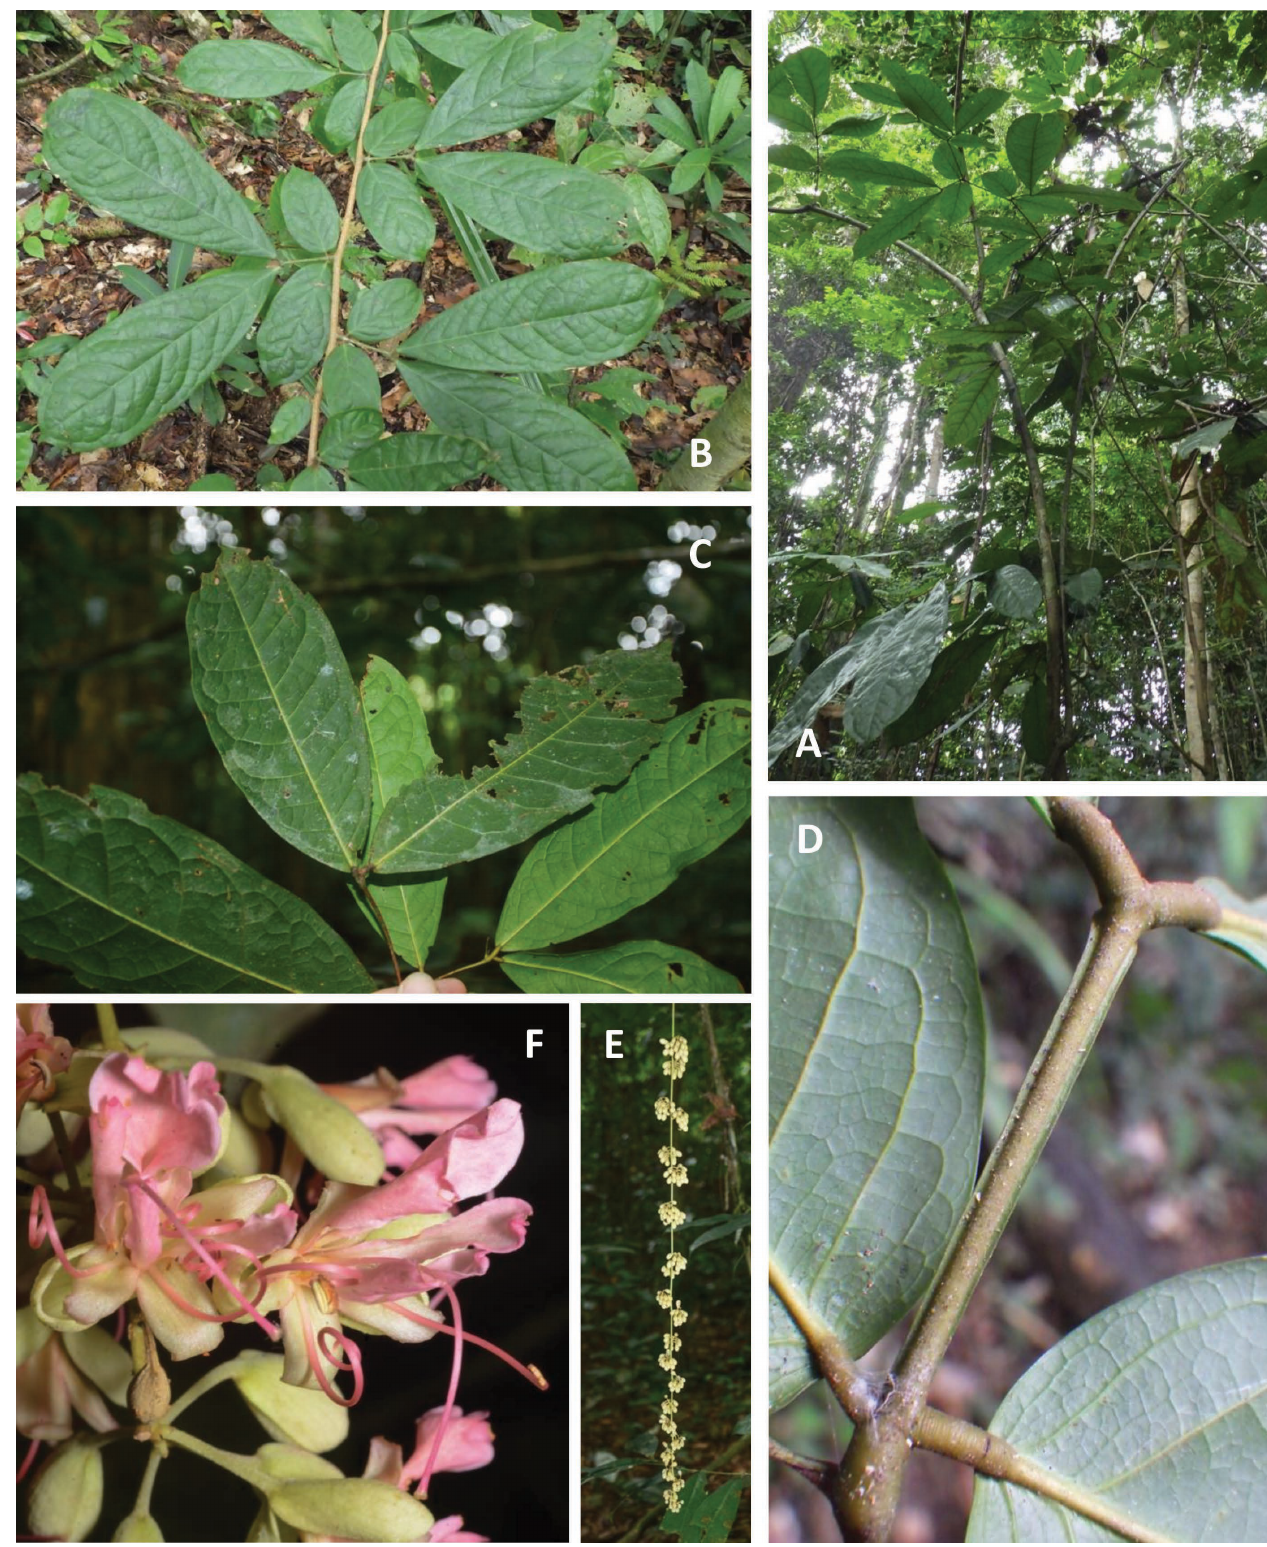
Figure 2 – Englerodendron nguemae . A . General view of the plant. B . Leaves, upper surface. C . Leaves, lower surface. D . Detail of the leaf rachis, lower surface. E . Inflorescence in bud. F . Detail of two open flowers. A, B, D from Lachenaud et al. 3313 ; C, E, F from Bidault et al. 2214 . Photographs: Olivier Lachenaud (A, B, D) CC-BY-ND, Ehoarn Bidault (C, E, F)